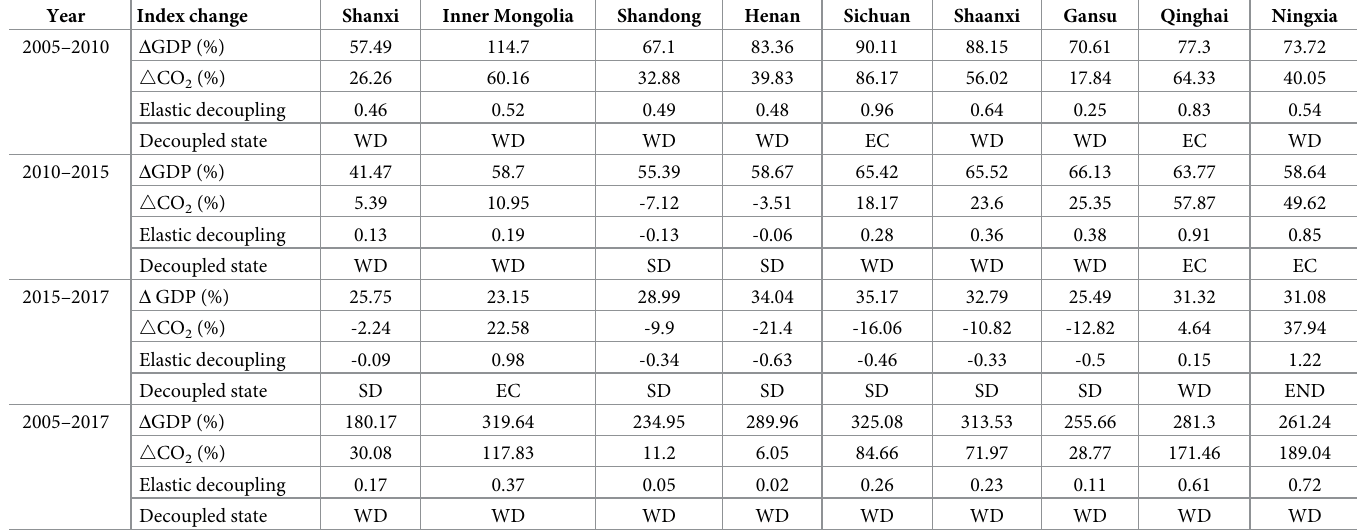
Table 3. Decoupling state for YRB regions over 2005–2017.